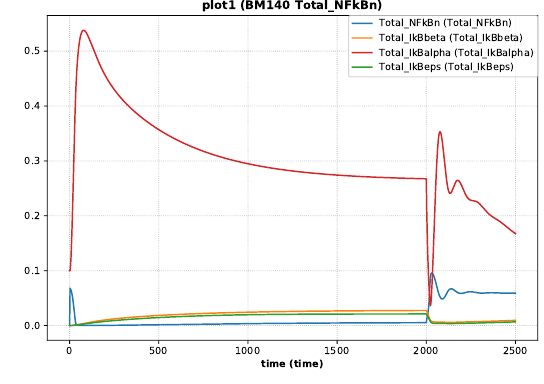
Figure A.19: The simulation result gained from the simulation description given in Listing A.11. Simulation with SED-ML web tools [2].